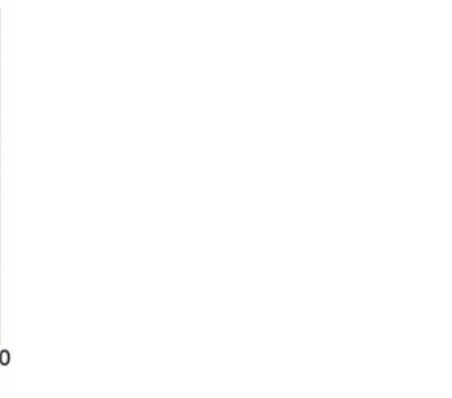
Figure 16. Ge-concentration in the fiber core as a function of position and temperature (reproduced from [65]).